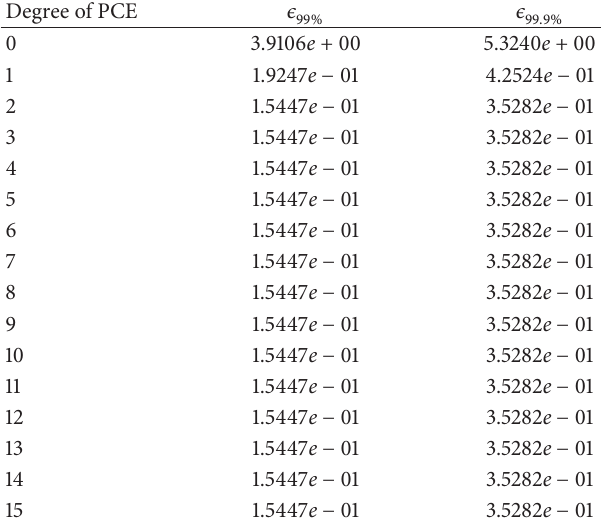
̂𝑄 ̂𝑄 99 % and 99.9 % of = 110 0